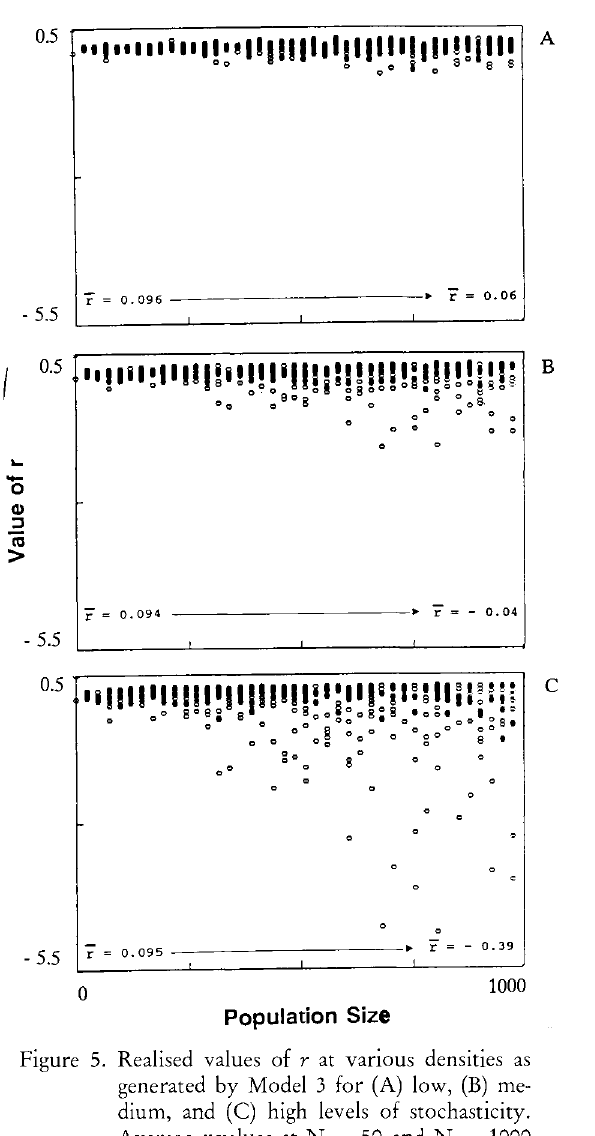
Figure 5. Realised values of r at various densities as generated by Model 3 for (A) low, (B) me dium, and (C) high levels of stochasticity. Average r-values at N = 50 and N = 1000 are presented at the bottom of each panel to illustrate the predictable decline of r with increasing population size. The full model was N t + 1 = N t e r ' s ' N ' where N re presented population size, and r (the popu